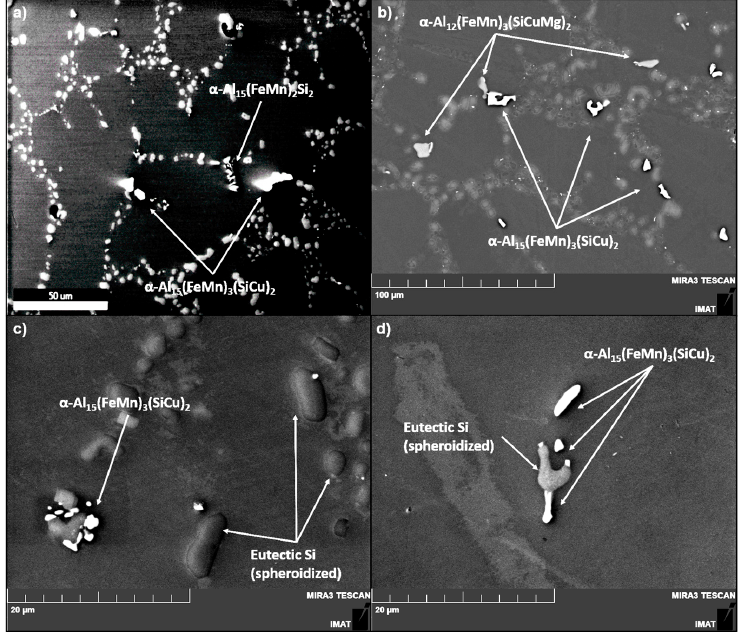
Figure 1. SEM images of the Al 7 SiCu 0.5 Mg alloy in SHT state showing the different phases